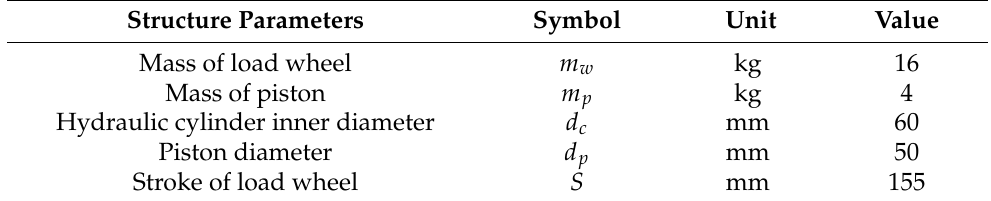
Table 3. Suspension structure